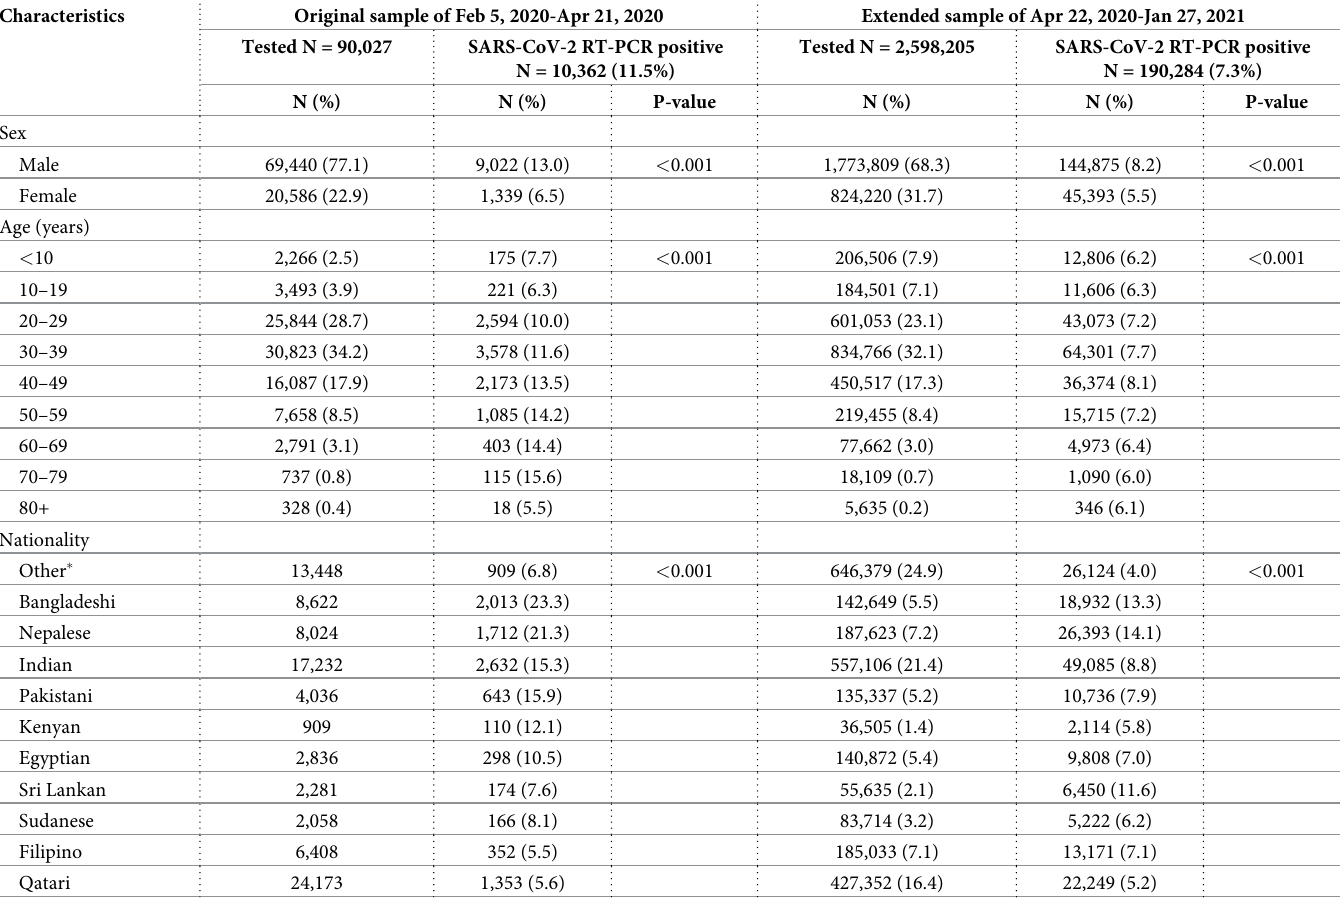
RT-PCR; real-time polymerase chain reaction � These include 148 other nationalities residing in